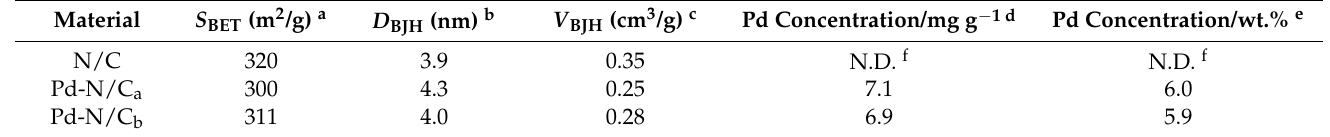
Table 1. Textural properties of the metal-supported N -doped carbonaceous